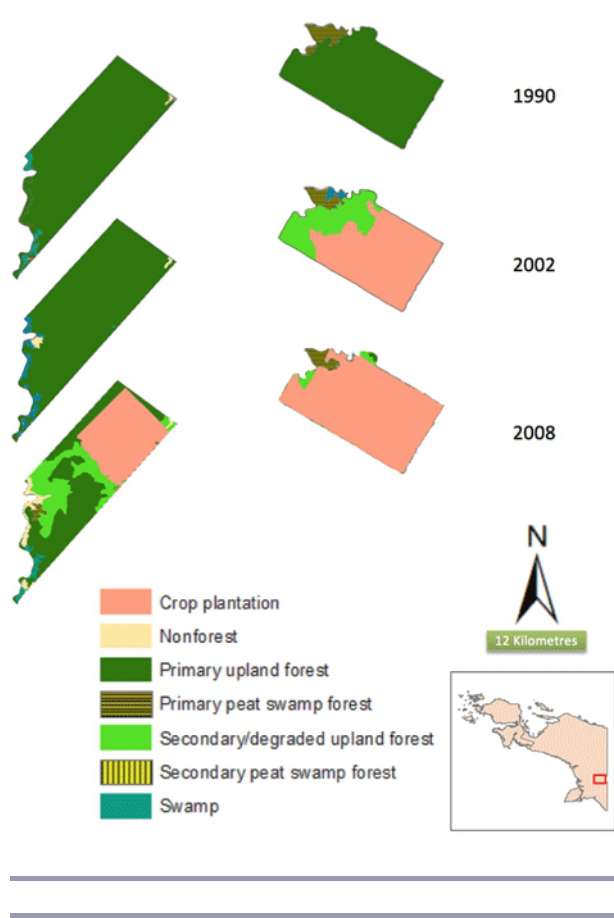
Fig. 4 . Land cover change analysis for site 3 in three time periods (a) 1990 (prior to plantation establishment); (b) 2002 (showing land clearing in Block A); and (c) 2008 (showing land clearing in Block B).